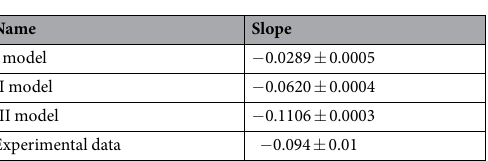
Table 3. Slopes estimated for the linear fits of simulated data and